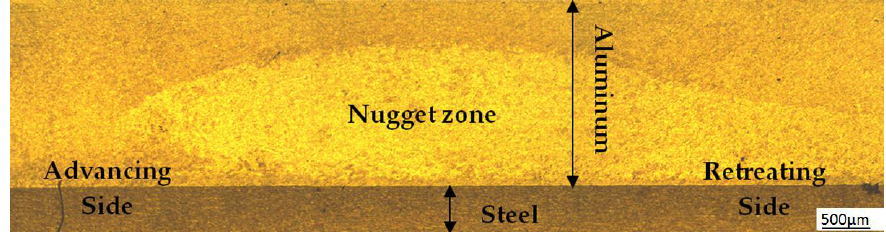
Figure 6. Optical microscopy of welded joint by friction stir welding of aluminum alloy AL6061-T6 to ultra-low carbon steel. Advancing speed of 200 mm/min.